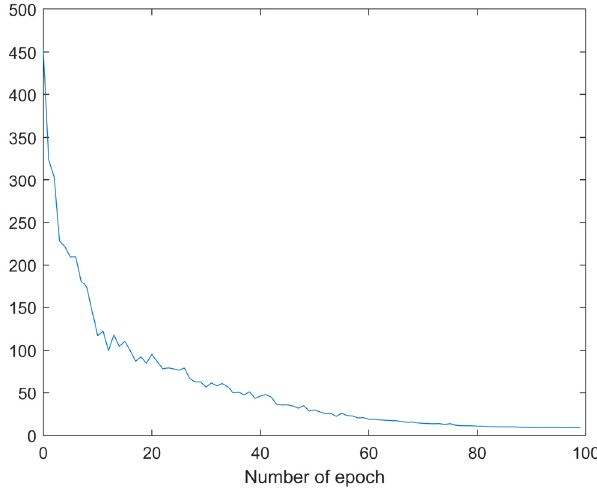
Figure 8. The change in loss function value during training process: mean–squared error for the simulate temperature field.